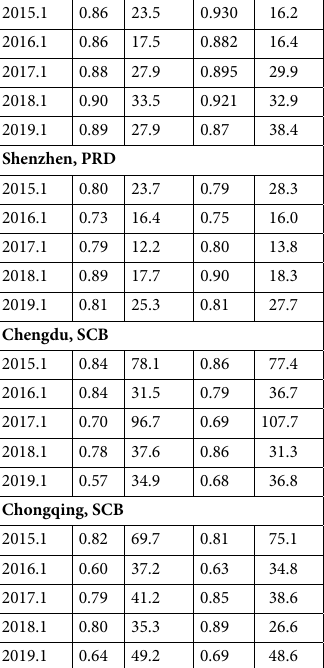
Table 2. Performance of machine learning in predicting hourly PM 10